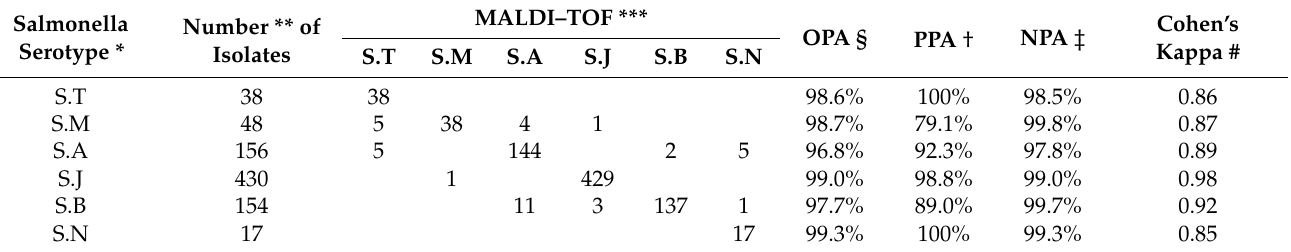
Table 1. Comparison of the results obtain from MALDI-TOF and conventional subtyping